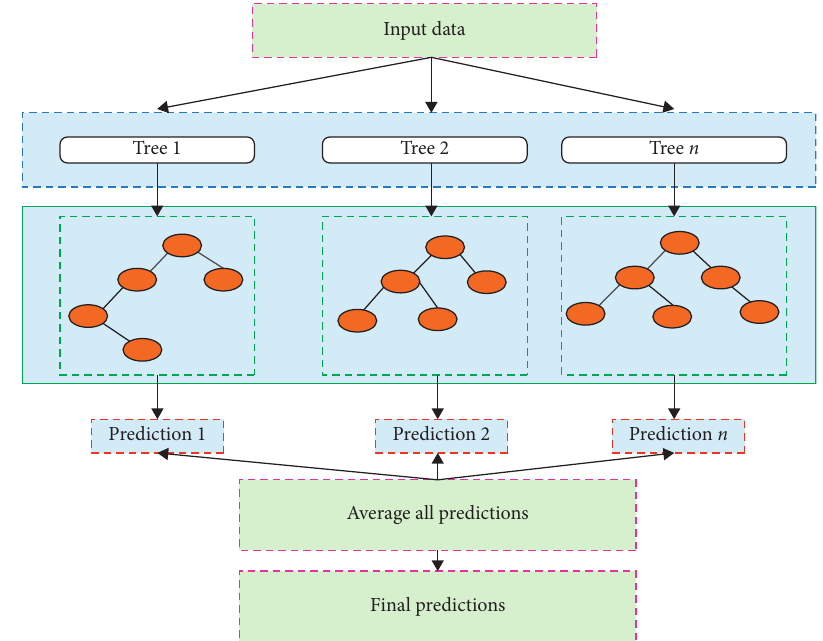
Figure 1: The random forest model structure.